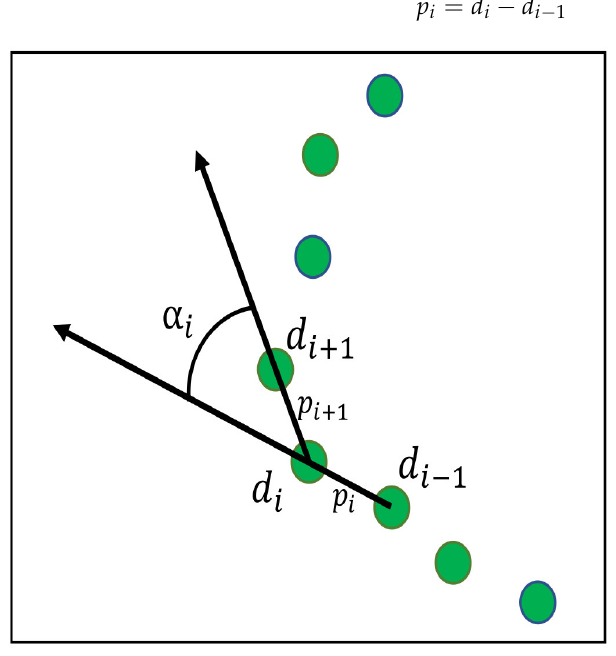
Figure 3. An RPOS-based segmentation presented in